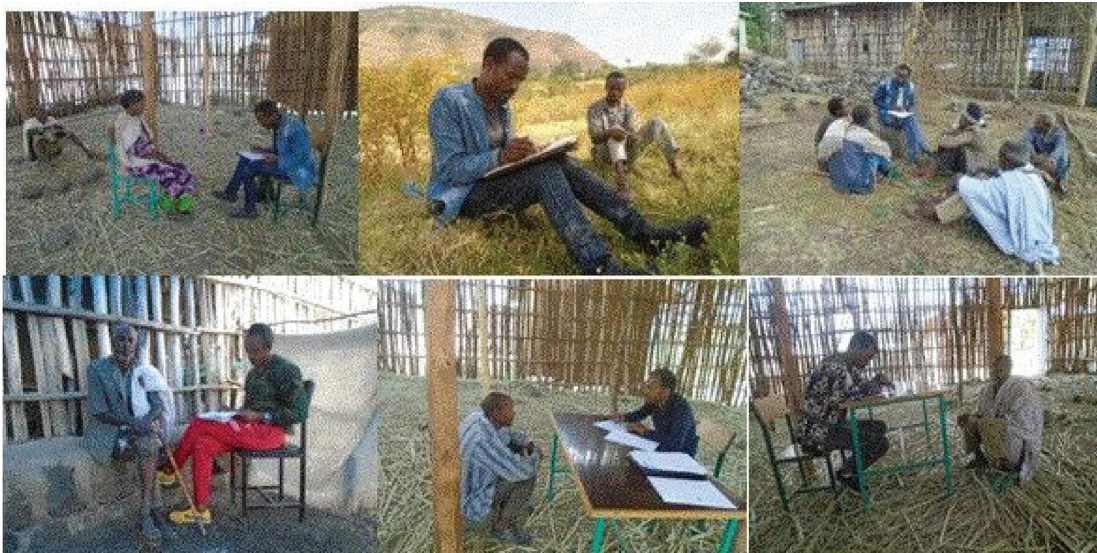
Figure 2: Individual household interview and group discussion during the social survey (Author,